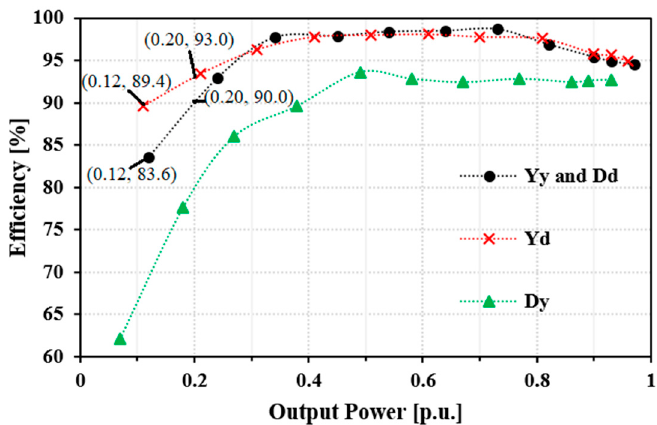
Figure 9. Efficiency versus output power curve of the 3P-BIDC with different transformer Figure 9. E ffi ciency versus output power curve of the 3P-BIDC with di ff erent transformer configurations configurations in continuous operation. in continuous